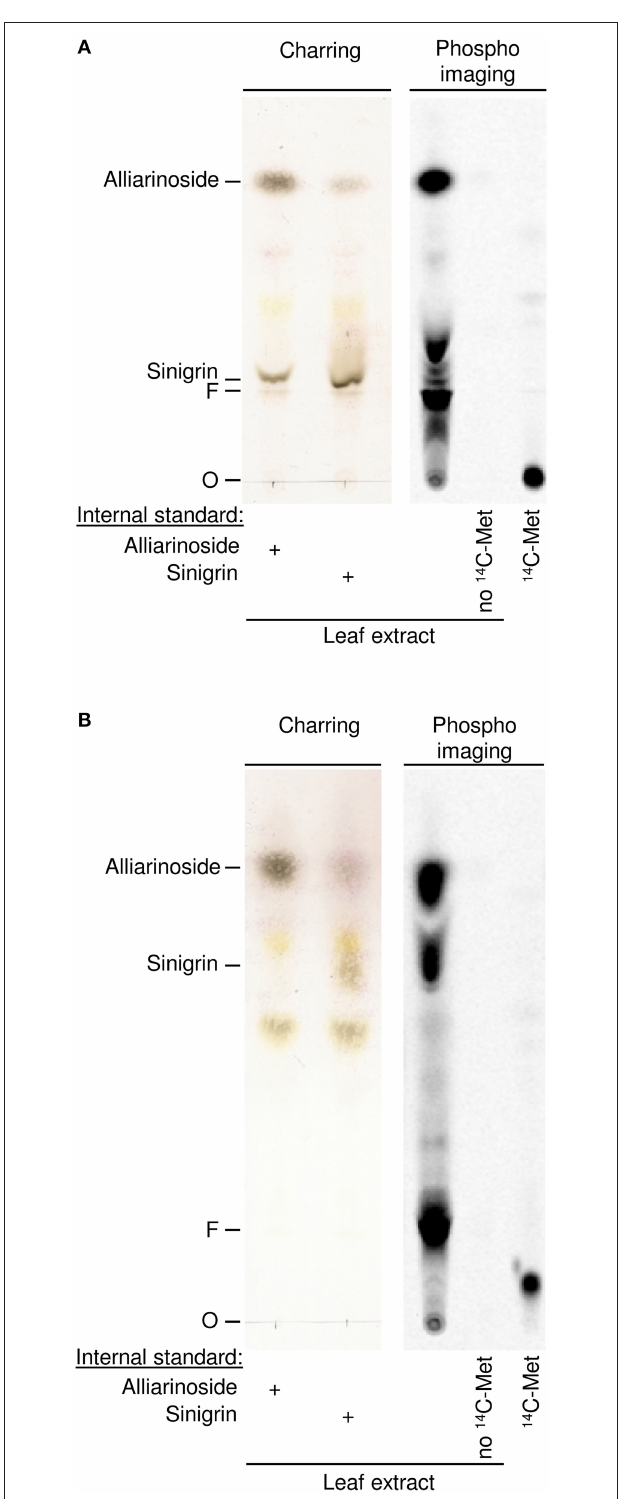
FIGURE 3 | Biosynthetic experiments documenting that alliarinoside (14) is methionine (1)-derived. [UL- 14 C]-methionine was administered to A. petiolata leaves and formation of radiolabelled products was monitored by